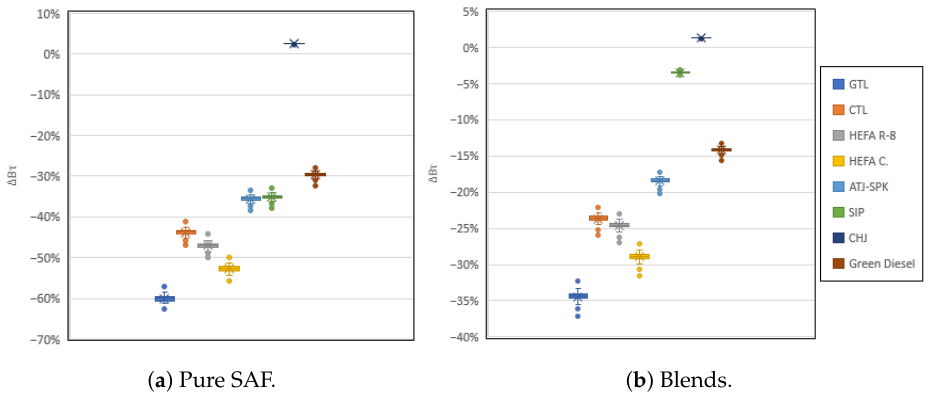
Figure 19. RDs in the product of contrail width by contrail optical depth for ambient relative humidities at formation of 58% or higher.